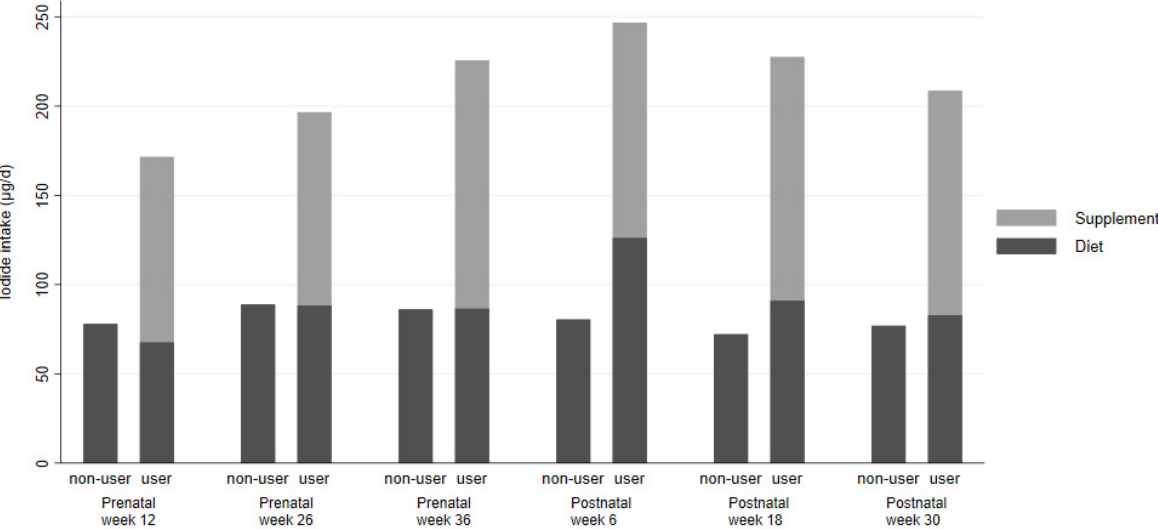
Figure 2. Geometric mean iodide intake from diet and diet plus supplements, at each study visit, by usage of iodine- containing supplements. Number of participants using supplements containing iodide at each study visit: n = 110, n = 98, n = 57, n = 17, n = 8 and n = 8, respectively. Number of participants not using supplements containing iodide at each study visit: n = 134, n = 119, n = 149, n = 189, n = 185 and n = 184, respectively.